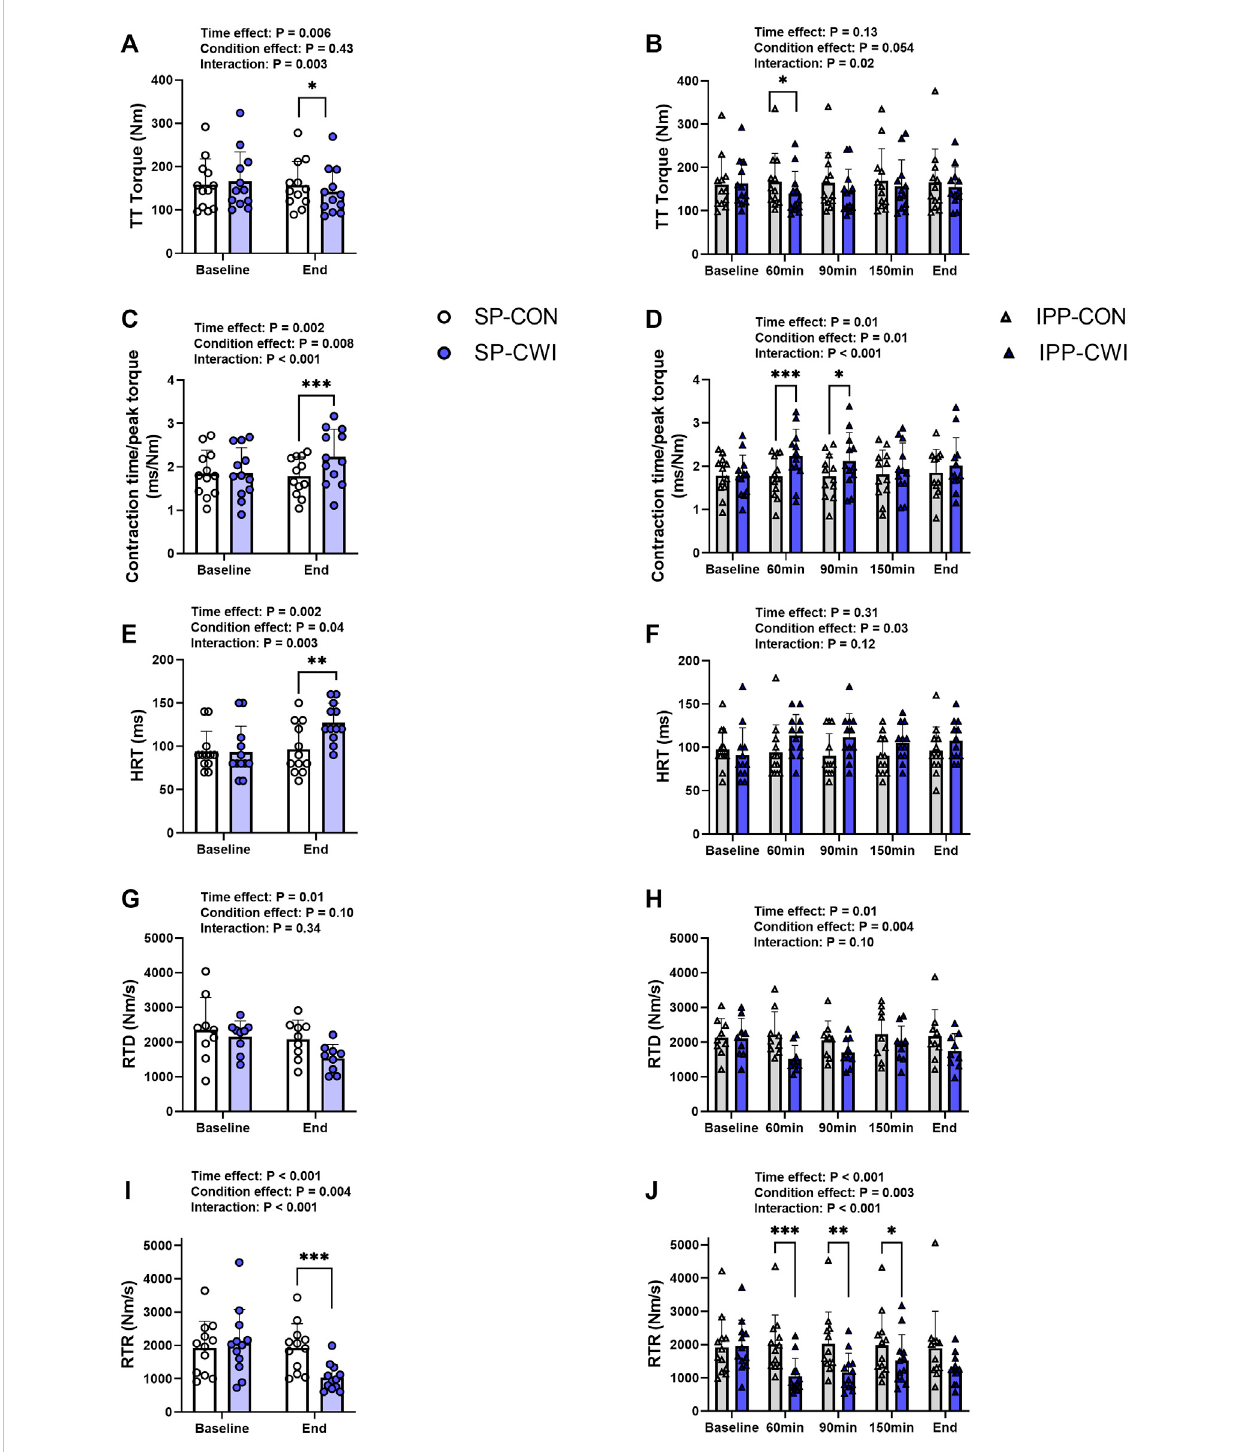
FIGURE 4 Peak torques and contractile properties derived from a 250-ms test train stimulation at 100 Hz (TT) in the unfatigued state. TT torques (A,B) , contraction time/peaktorque (C,D) ,half-relaxationtime(HRT) (E,F) ,peakrateoftorquedevelopment(RTD) (G,H) andpeakrateoftorquerelaxation(RTR) (I,J) duringthesingle and intermittent/prolonged phases, respectively. Data are shown as mean ± SD and all panels include individual values. SP, single phase; IPP, intermittent/ prolonged phase. *, p < 0.05; **, p < 0.01; ***, p < 0.001: Signi fi cant differences CON vs. CWI. N = 12 for all parameters except for RTD (N = 9) (G,H)